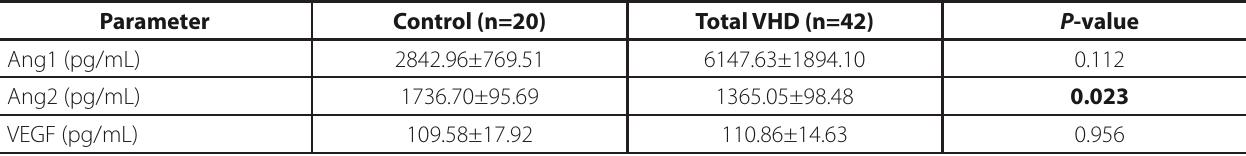
Table 2. Ang1, Ang2, and VEGF levels in control group and VHD